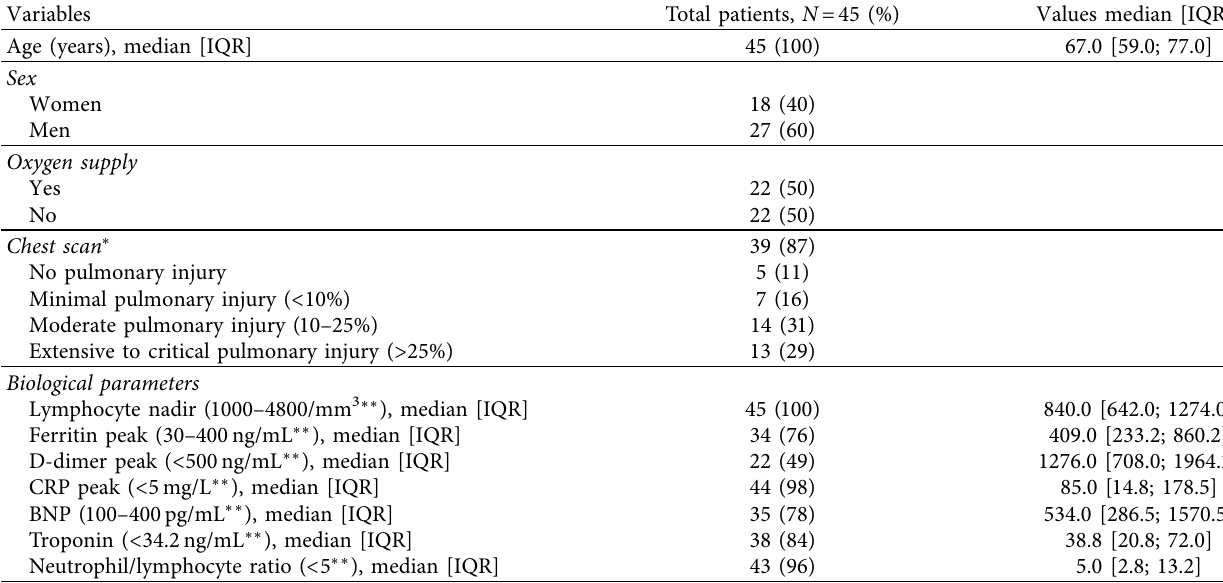
Table 1: Characteristics of symptomatic patients on maintenance hemodialysis ( N � 45) diagnosed as infected with SARS-CoV-2 from March to April of the epidemic and who were still alive 6 months